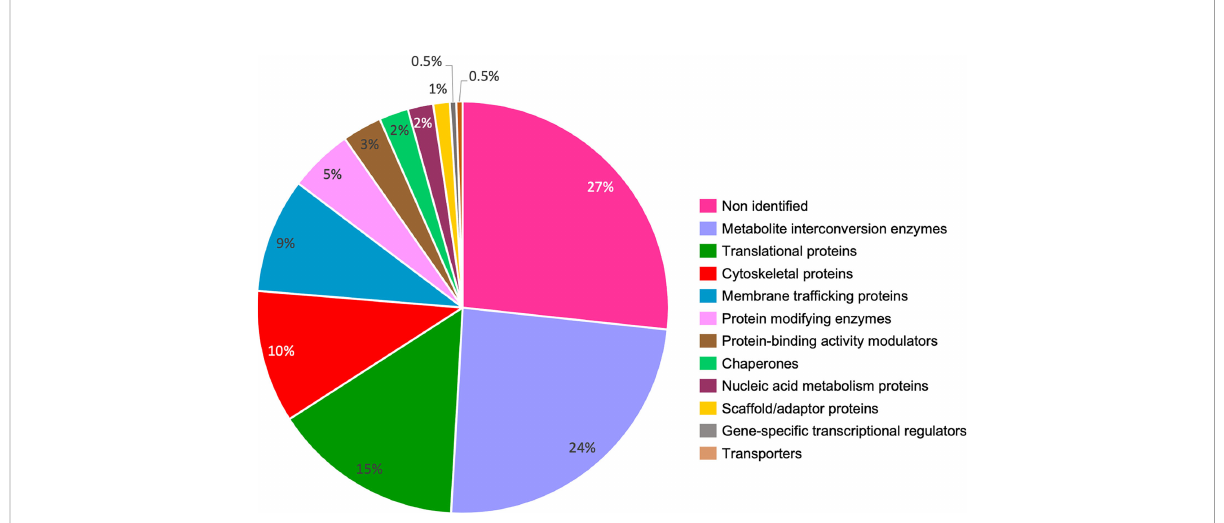
FIGURE 6 E. histolytica secreted proteins that associate to LBPA. Secreted proteins from cultured trophozoites were immunoprecipitated with an a -LBPA antibody as previously reported (Castellanos-Castro et al., 2016a). To remove the background, secreted products were pre-cleared with recombinant protein G (rProtein-G) agarose ON, previous to the incubation with the speci fi c antibody ( a -LBPA). The LBPA-bound proteins were identi fi ed by mass spectrometry (LC-ESI-HDMSE) in the Proteomics Unit of LaNSE (National Laboratory of Experimental Services) at CINVESTAV. Then, theoretical astringent conditions were performed to eliminate proteins with low con fi dence values. Proteins (221) were organized by biological processes using the Panther server.